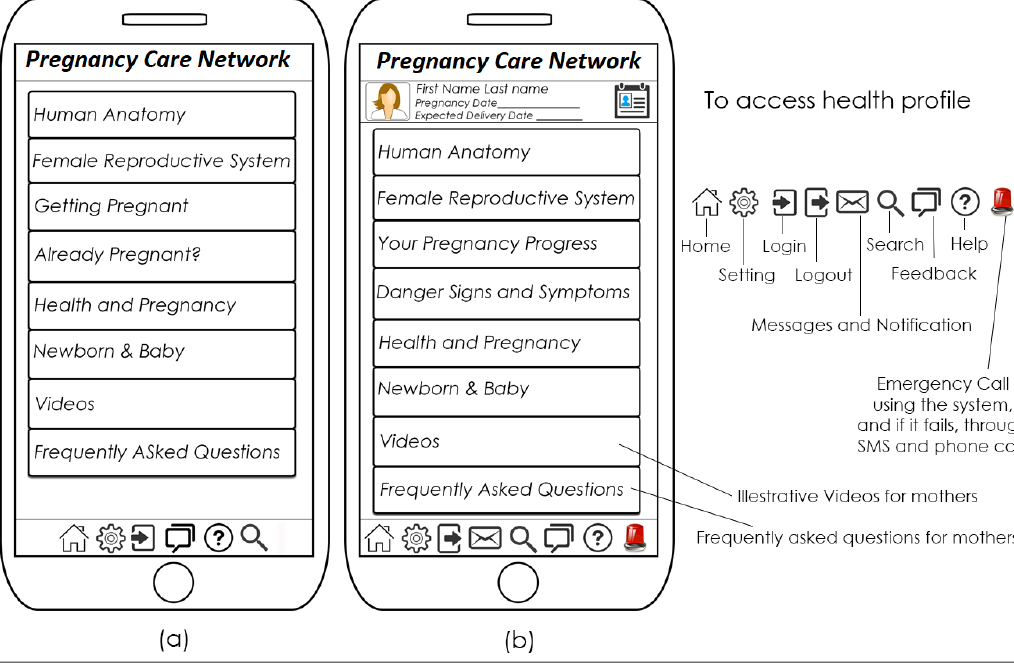
Figure 5. ( a ) Main screen for guest users; ( b ) main screen for registered pregnant women, with the explanation of the icon